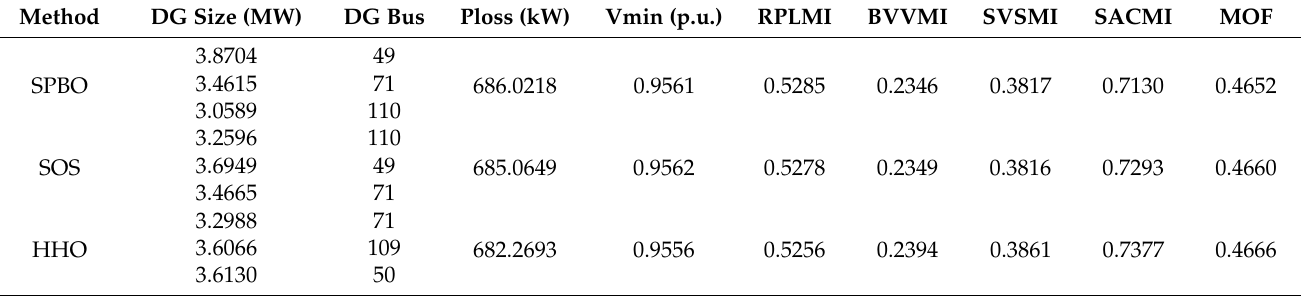
Table 6. Comparison of results for exclusive PV-DG allocation (case-3) for 118-bus test